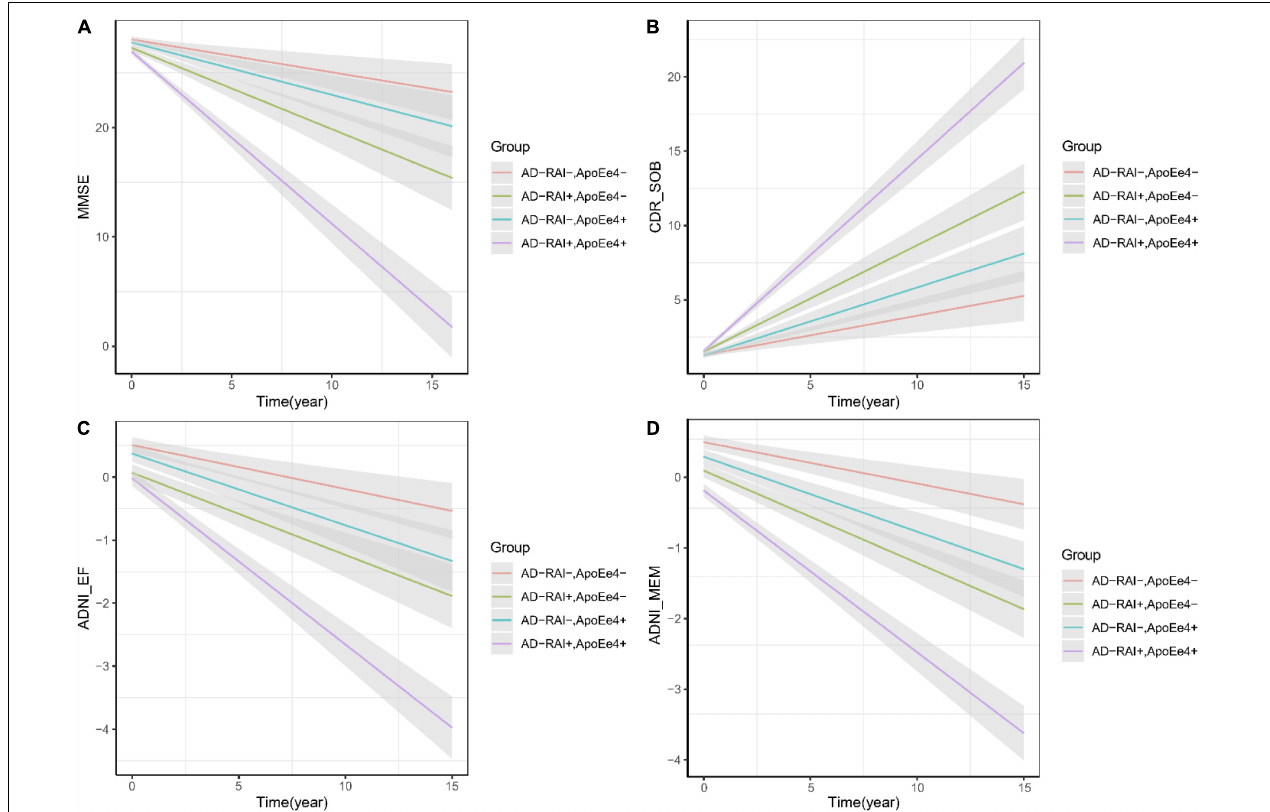
FIGURE 2 | AD-RAI and APOE- ε 4 as predictors of cognitive decline of MCI patients. Both AD-RAI-positive groups and APOE- ε 4 + groups showed faster decline of memory (D) and executive ability (C) than their corresponding control groups. In our analysis, APOE- ε 4+ failed to predict a faster decline of MMSE scores (A) among MCI patients with AD-RAI < 0.5 at baseline, but it was found to further amplify the acceleration of cognitive decline (A–D) in those with AD-RAI > 0.5.